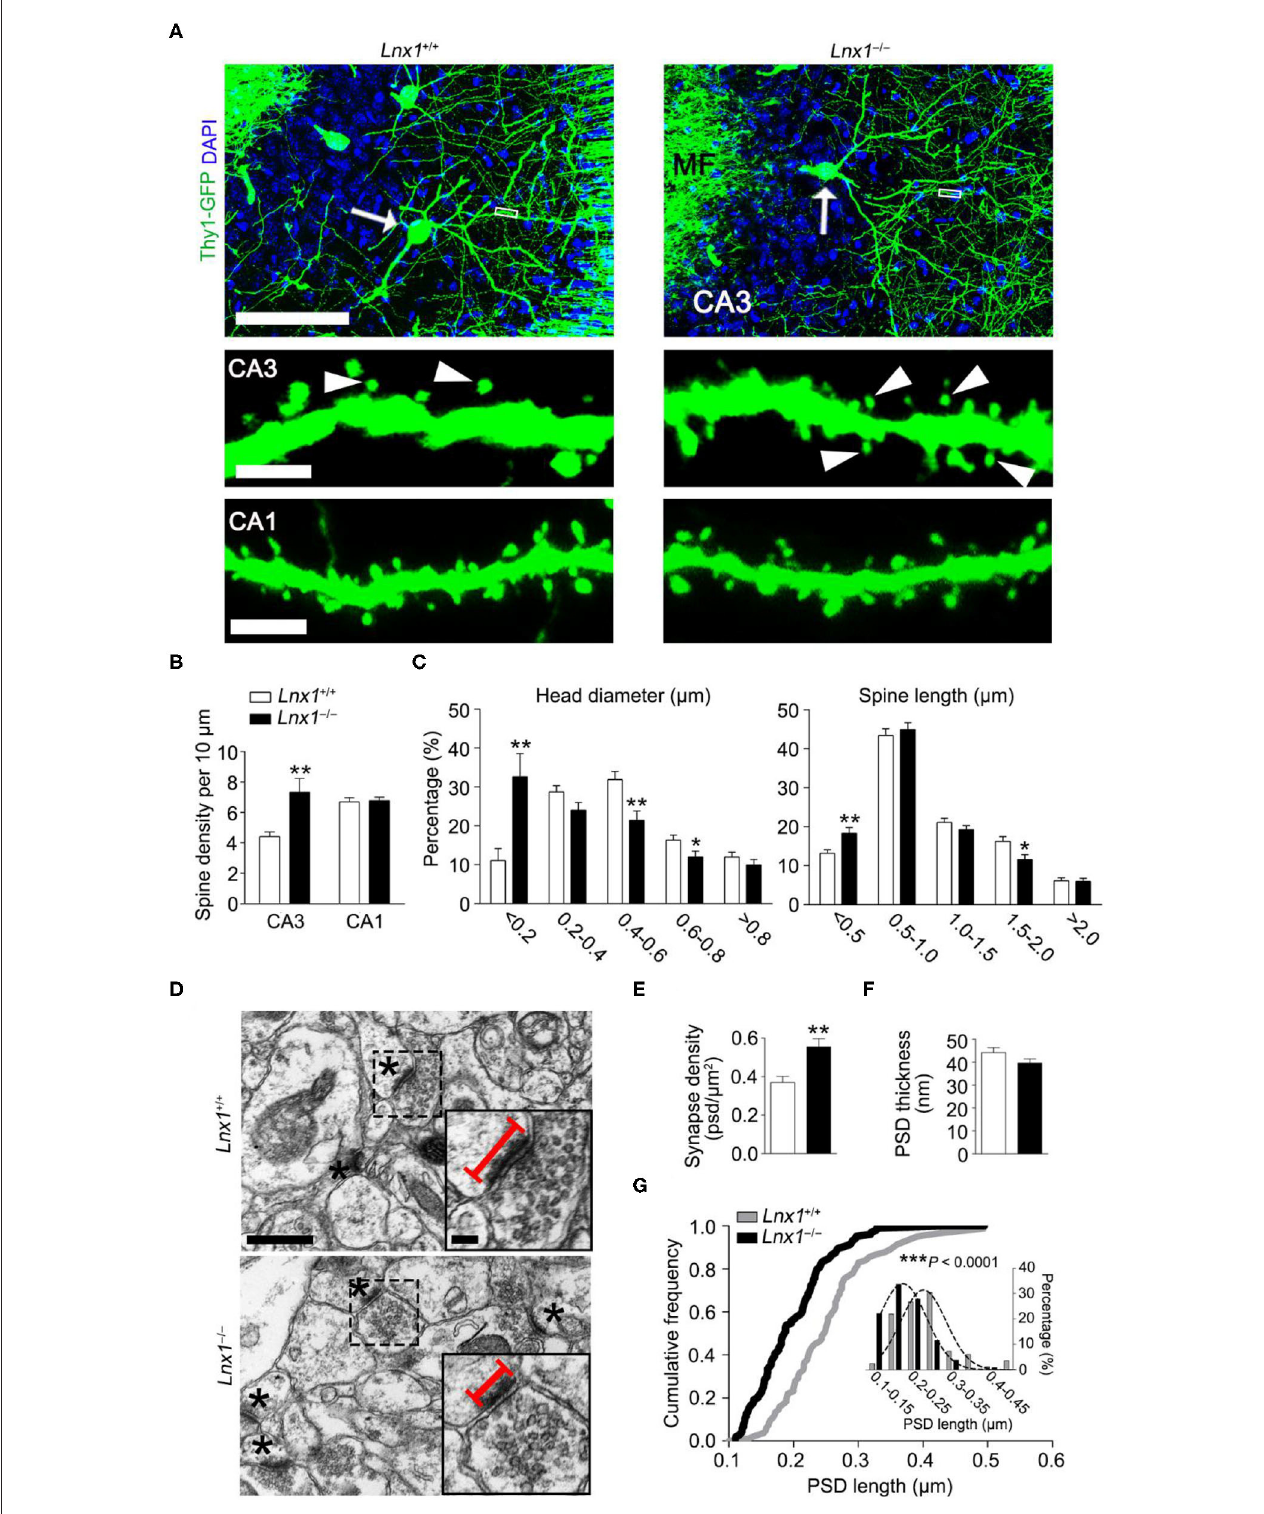
FIGURE 1 | Ligand of Numb protein X 1 (Lnx1) is required for spinogenesis in CA3 neuron. (A) Spine morphogenesis in CA3 and CA1 neurons from PW3 Lnx1 + / + and Lnx1 − / − mice. Arrows delineate neurons (upper panel) with the mushroom spine (arrowheads in lower panel). Scale bars represent 100 µ m (upper panel), 2.5 µ m (middle panel), and 3 µ m (lower panel). MF, Mossy Fiber. (B,C) Quantification of the spine density in CA3 neurons and CA1 neurons. Percentage distribution of spine